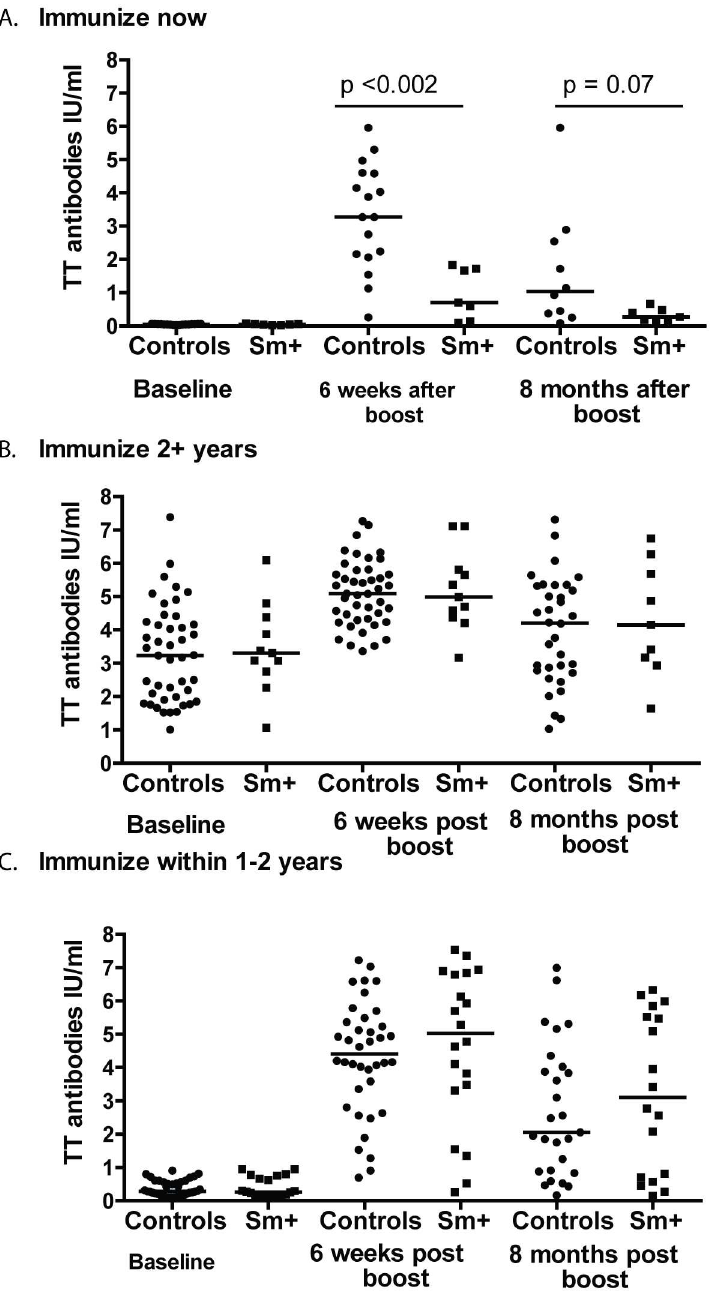
Fig 3. Individuals in need of immediate tetanus toxoid boost with a concomitant schistosomiasis infection do not respond as robustly to vaccination as compared to individuals without schistosomiasis at the time of vaccination. Participantswere allocatedto groups basedon their need for a vaccine boost as determined by their baselinetiters: Immunize now < 0.1mIU/ml (A.); immunizewithin 1–2 years 0.1 to 1.0 mIU/ml (B.); Immunize 2+ years > 1.0mIU/ml (C.). Anti-tetanus toxoid (TT) titers were measuredby ELISA at baseline,6 weeks after boost, and 8 months after boost. Circles represent study controls, individualsat baselinenegativefor S . mansoni and STHs, and squaresrepresent those who were schistosomiasis positive at baseline.Bars represent mediananti-TT levels at each time point and statistical differences at each time point were determined using the Mann-Whitney test with a p < 0.05 considered statistically